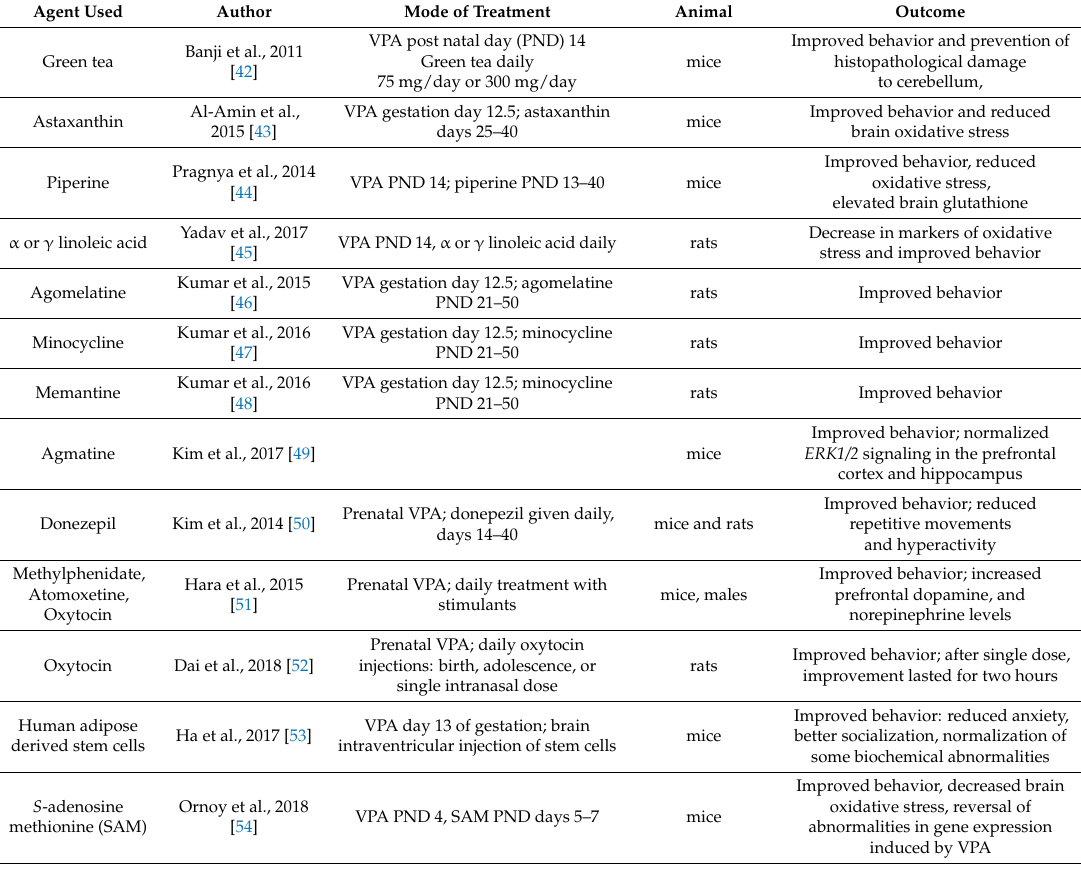
Table 1. The different studies demonstrating the amelioration or reversal of symptoms in valproic acid (VPA)-induced autism spectrum disorder (ASD)-like behavior. The order is the appearance in the text of the